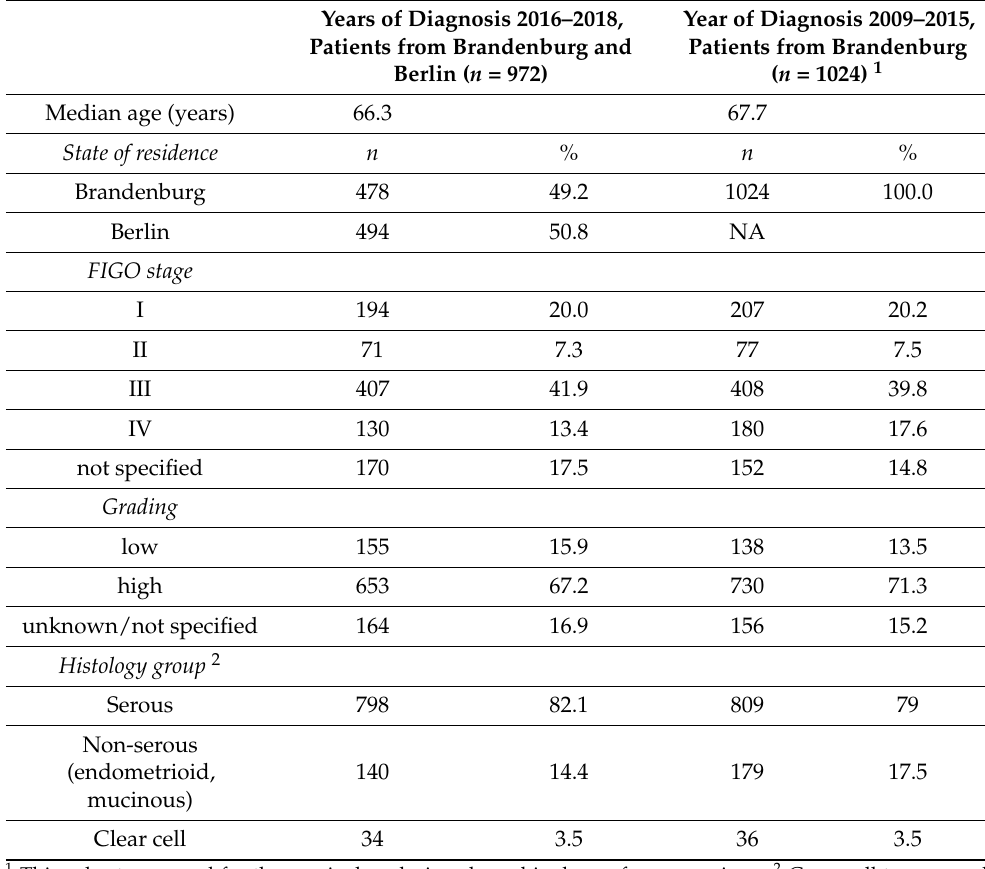
Figure 2. FIGO stages according to histopathological subtype, years of diagnosis 2016–2018 ( n = 972, years 2016–2018). Table 1. General cohort characteristics.